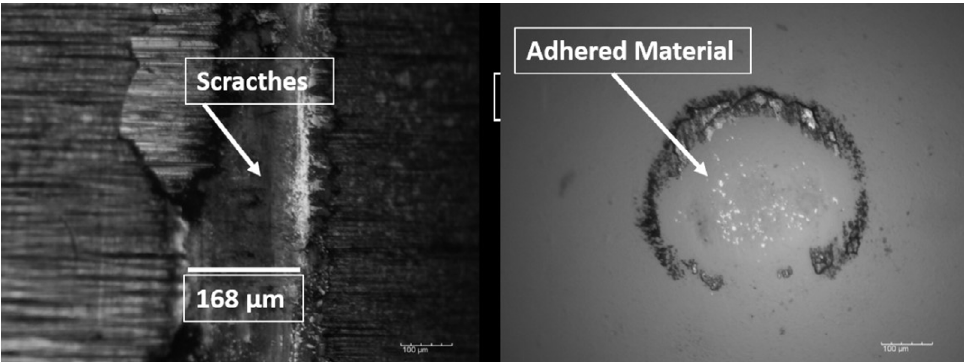
Figure 6. Worn track for the EN 320-9 condition: a) wear pattern; b) counter-face